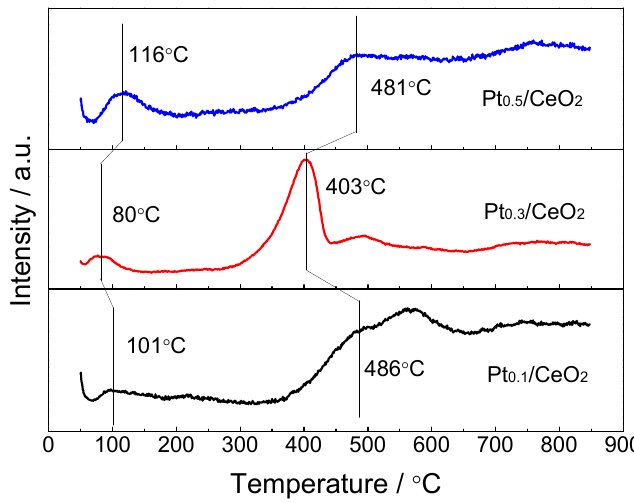
Figure 9. H 2 temperature-programmed reduction (H 2 -TPR) profile of Pt 0.1 / CeO 2 , Pt 0.3 / CeO 2 and Pt 0.5 / CeO 2 catalysts.